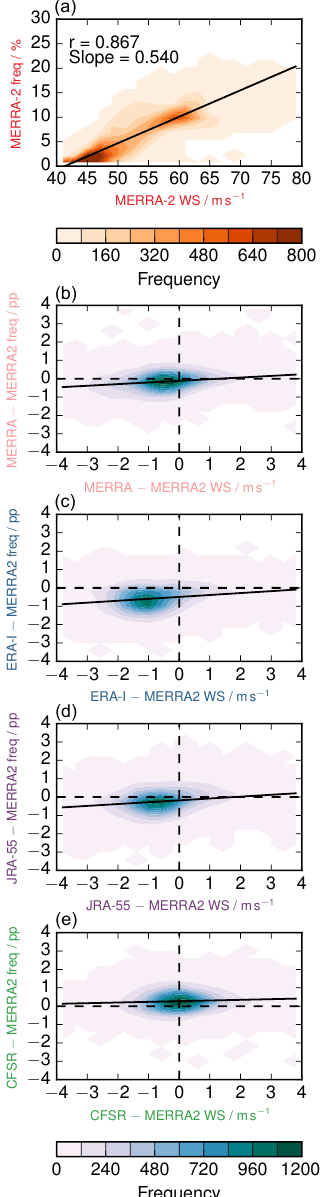
Figure 14. Density plots of (a) MERRA-2 climatological daily jet frequencies versus climatological daily jet wind speeds (WS; values are from Fig. 13) and of the corresponding (reanalysis − MERRA- 2) frequency differences versus jet wind speed differences for (b– e) MERRA, ERA-I, JRA-55, and CFSR. Black lines are the linear fit to the